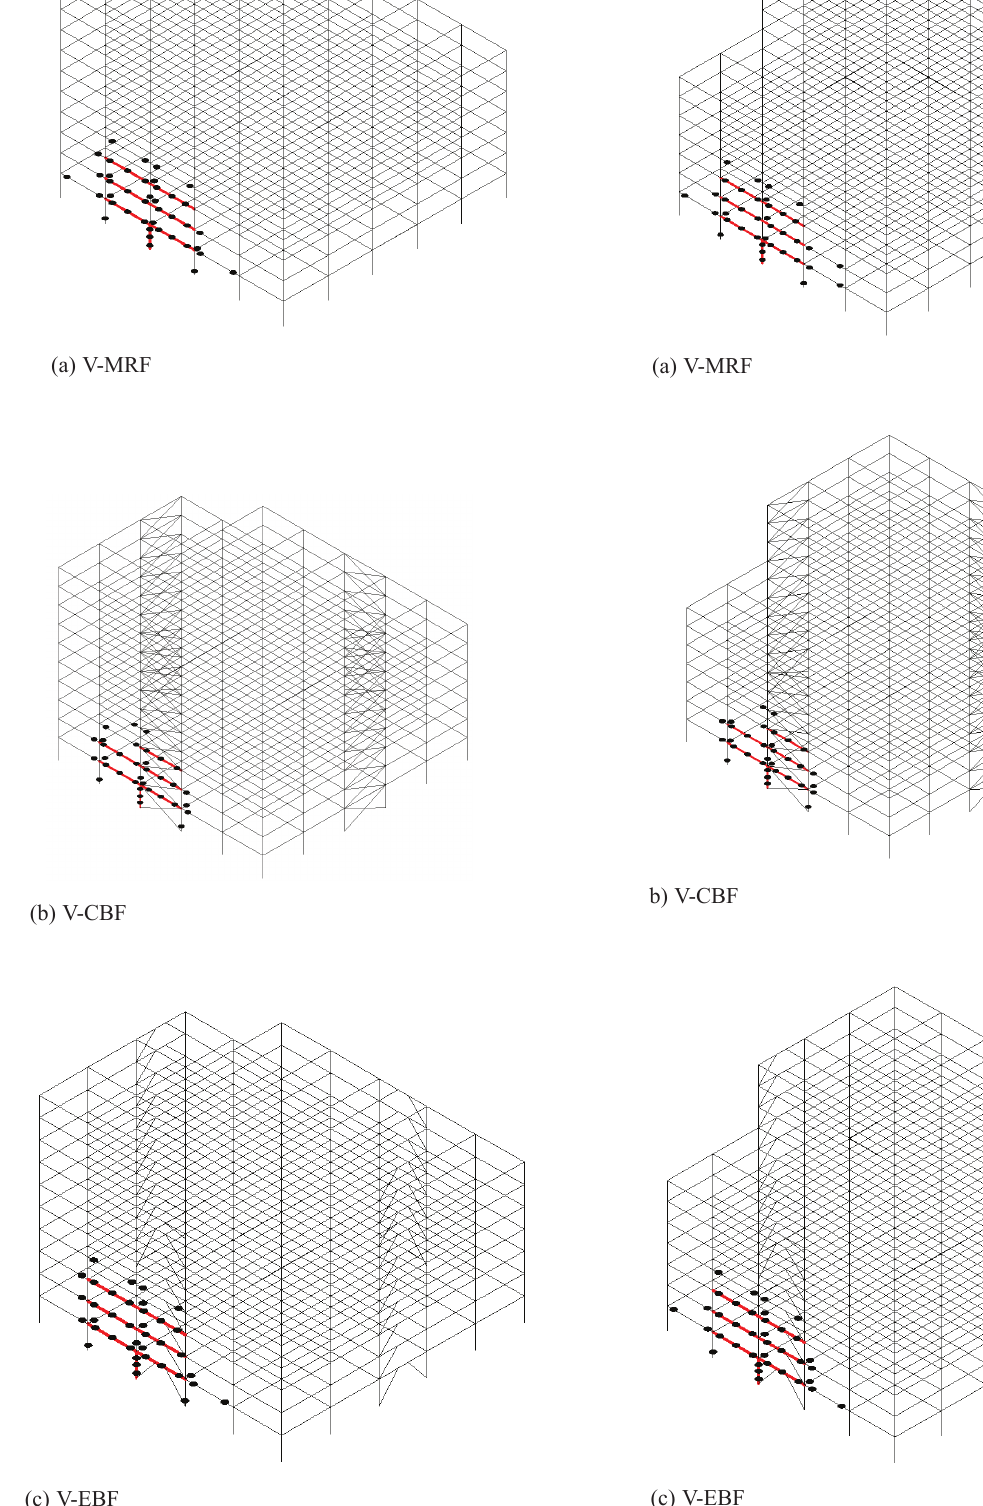
Fig. 8. Member failure and plastic hinge locations for vertically irregular MRF, CBF, EBF – Blast